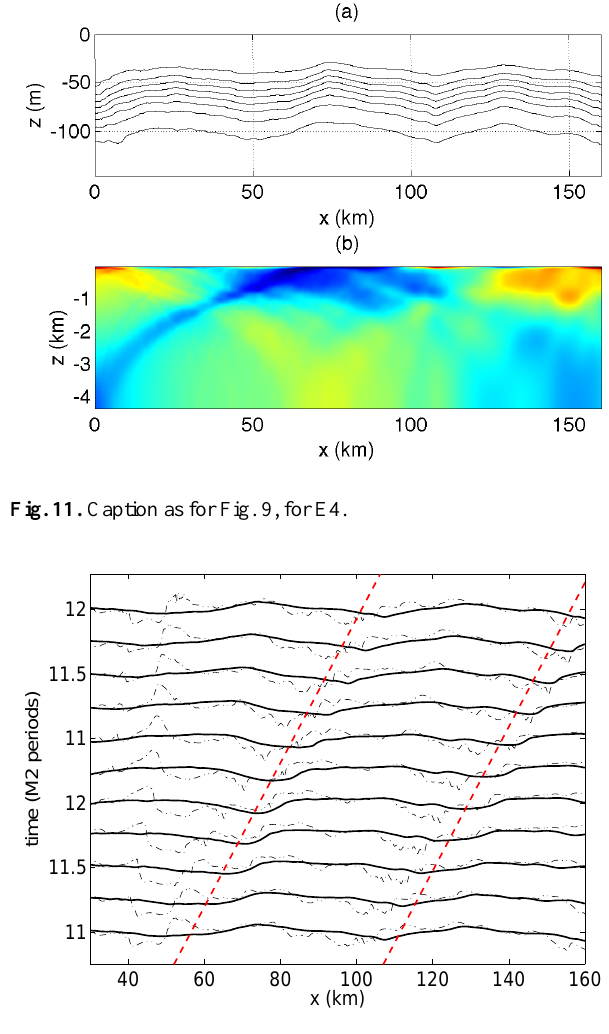
Fig. 12. Caption as for Fig. 4, except that two isopycnals on the left side of the pictures are separated by 1 / 10 M2 periods and also by 40m in terms of displacement amplitude. Solid lines refer to E4, dash-dotted lines to